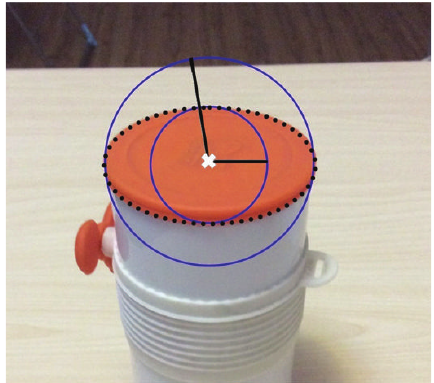
Figure 3: Symmetry detection under affine transformations. The long axes can be estimated as the maximum value of all extreme value points of radius, while the short axes are the radius with the maximum value of